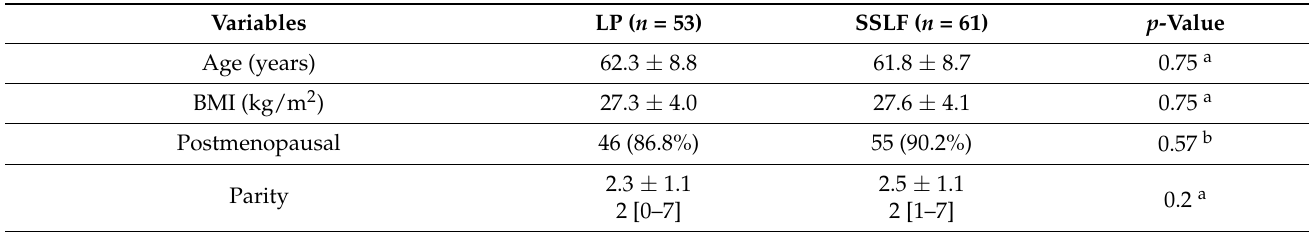
Table 1. Patient characteristics and perioperative